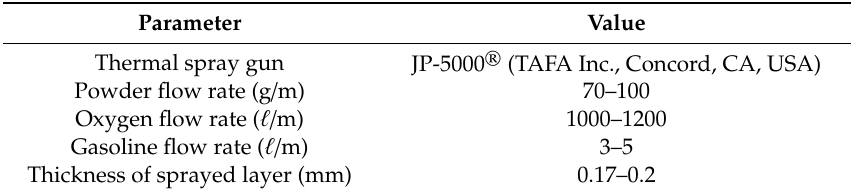
Table 2. Thermal spraying conditions